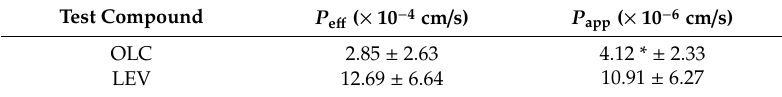
Table 2. Permeability coe ffi cients ( P e ff ) and apparent permeability coe ffi cients ( P app ) of oleocanthal and levofloxacin. Results are expressed as the mean ± SD of n = 4. Data are normalised to a 10-cm intestinal segment.